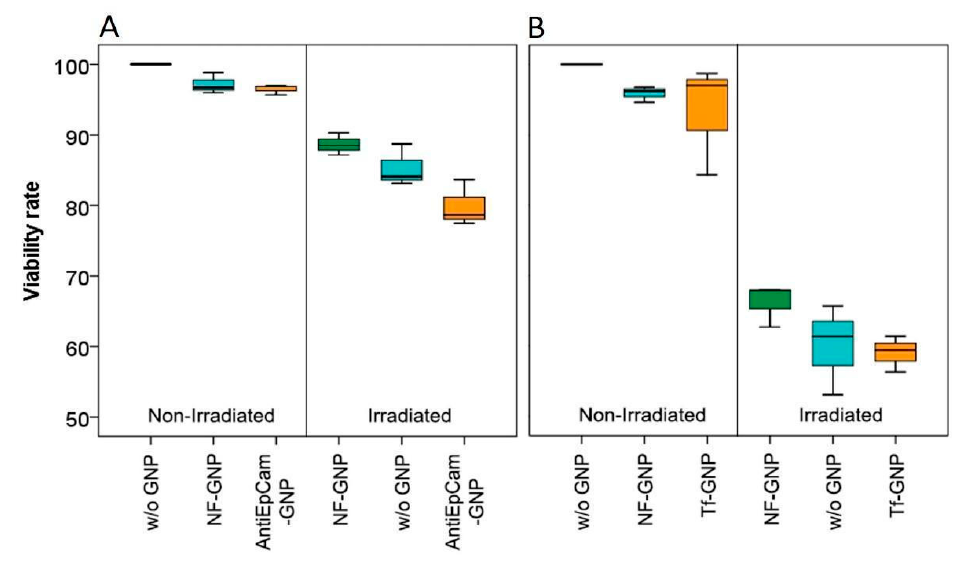
Figure 10. Viability rates of Caco2 ( A ) and SKBR3 ( B ) cells, left, non-irradiated and right, 24 h after irradiation. From left to right, the boxes mark the viability of cells in the absence of GNPs (w/o GNP), in the presence of non-functionalized GNPs (NF-GNP) and in the presence of functionalized GNPs (AntiEpCam-GNP and Tf-GNP, respectively).